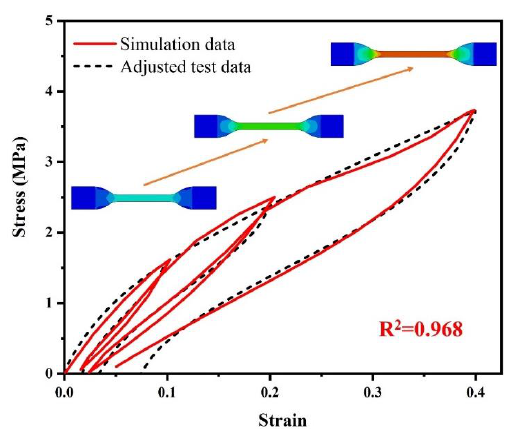
Figure 12. The comparison between the simulation data and adjusted test data of tensile recovery mechanical response of hard apex dumbbell-shaped rubber